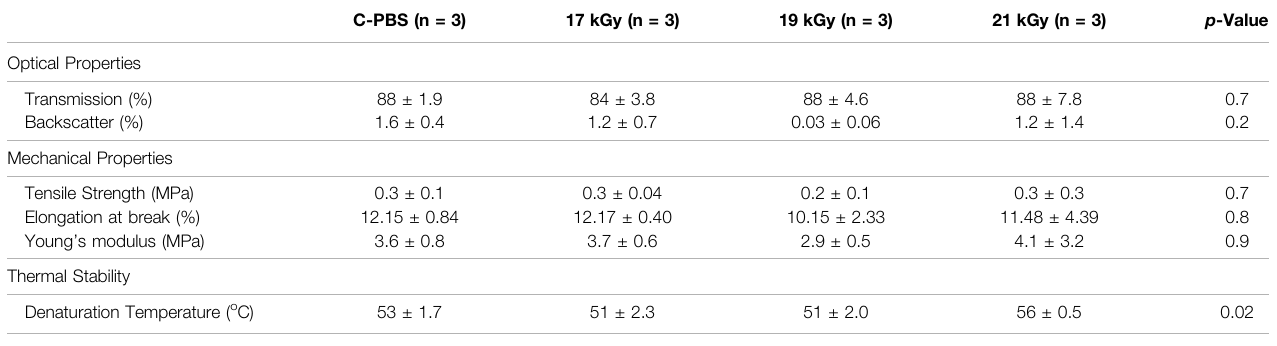
TABLE 1 | Comparison of physical properties of e-beam irradiated and unirradiated corneal implants. Mechanical and optical properties of irradiated and unirradiated implants. C-PBS (n = 3)